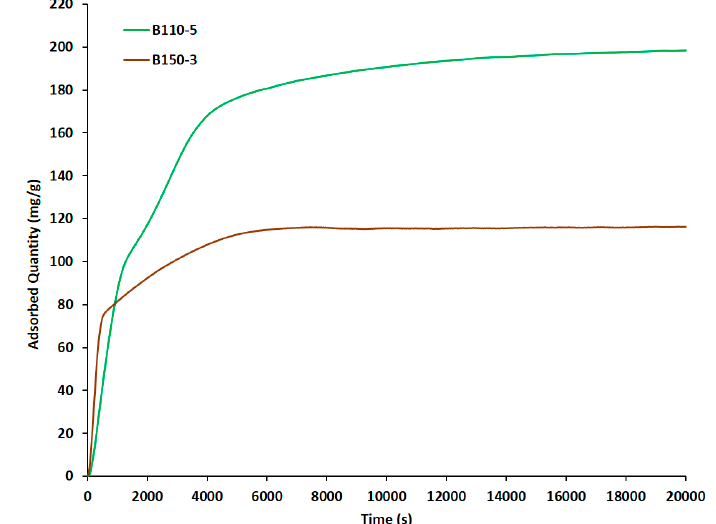
Figure 8. Adsorption kinetic of n ‐ hexane at 25 °C and p/p° = 1 with silicalite ‐ 1 beads synthesized at 110 °C for 5 days (B110 ‐ 5) and hollow spheres synthesized at 150 °C for 3 days (B150 ‐ 3).